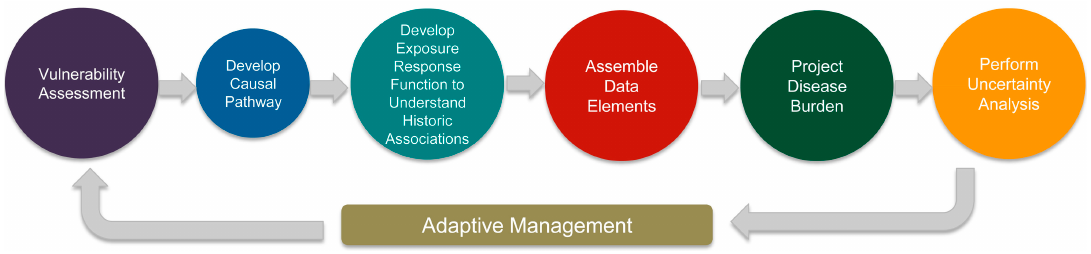
Figure 5. The process used by the Florida BRACE Program for developing disease burden projections. Adapted from the Centers for Disease Control and Prevention (CDC), 2016.